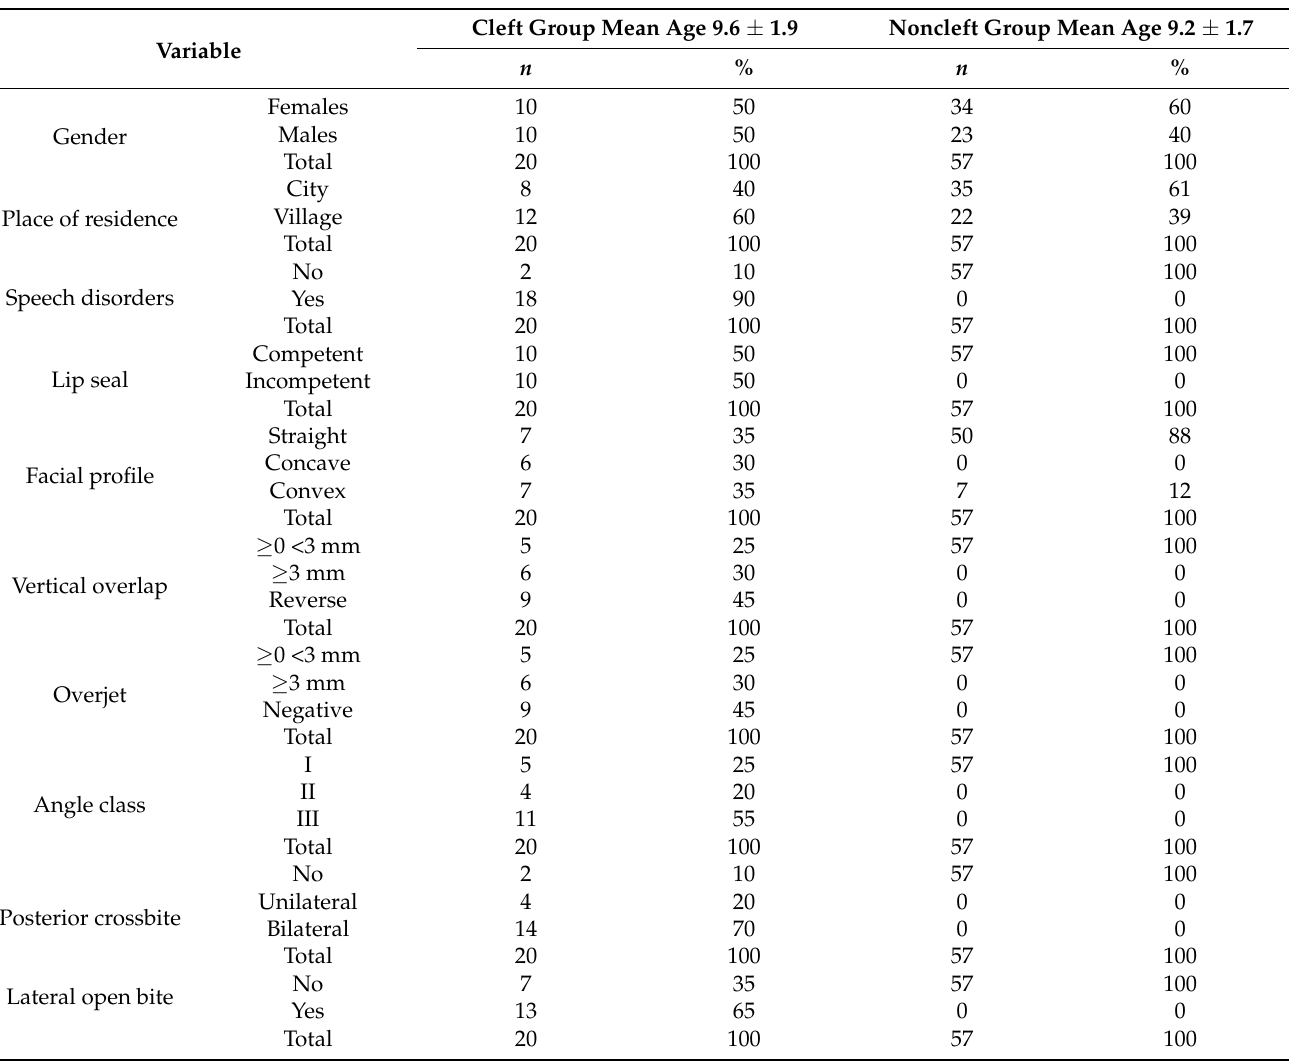
Table 1. The characteristics of the cleft and noncleft